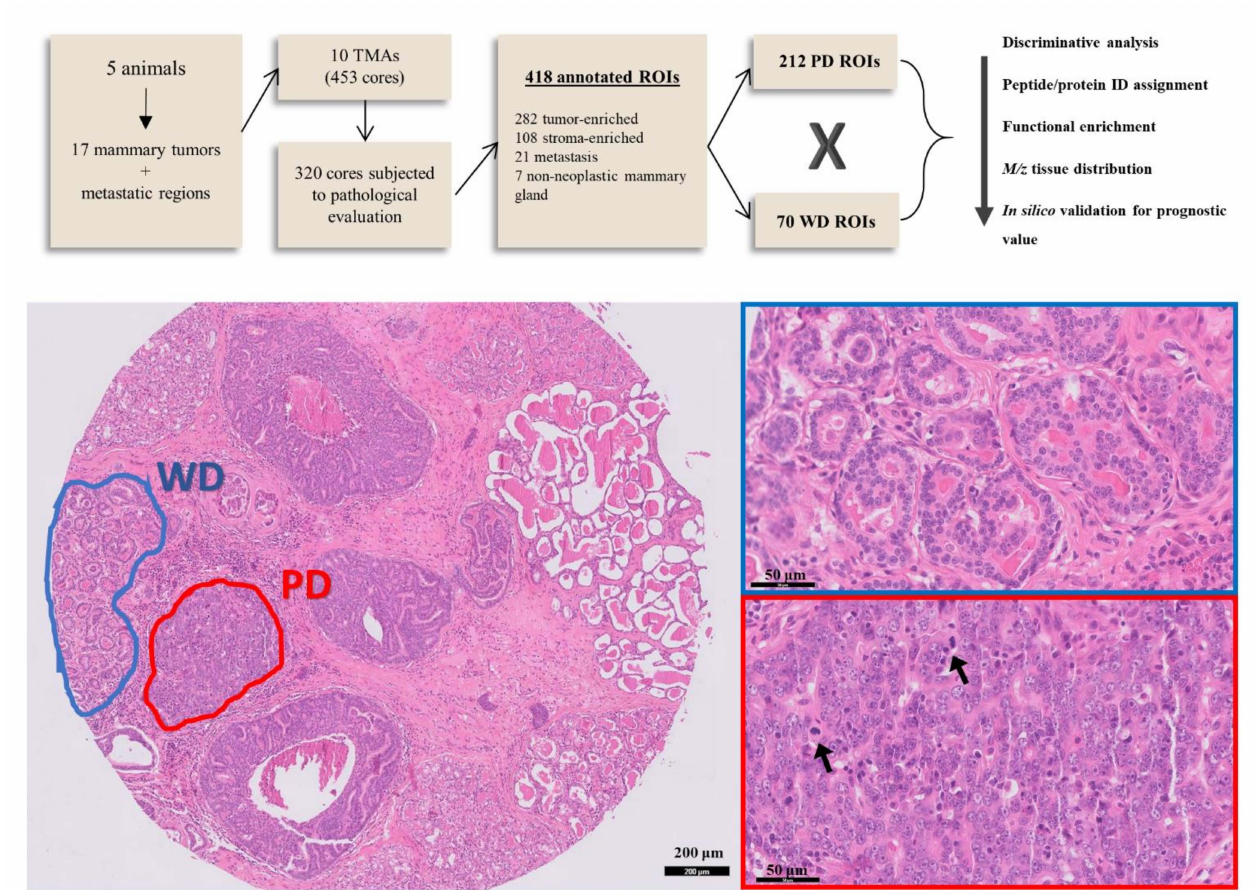
Figure 1. Peptide expression was compared between neoplastic cell populations in two distinct levels of differentiation (well-differentiated, WD, and poorly differentiated, PD), from 17 tumor samples assembled in FFPE tissue microarrays. Protein identity assignment of significant features was performed based on mass matching to an LC-MS/MS derived peptide database. Protein IDs were then submitted to functional enrichment analysis and promising prognostic marker candidates were validated in silico using a human gene expression database. HE stained TMA core shows the annotation of a WD (blue) and a PD (red) region of interest (ROI), detailed in the images on the right. ROIs were classified based on morphological criteria such as tubule differentiation, cell, nuclei, and nucleoli pleomorphism. Arrows point to atypical mitoses inside a PD tumor